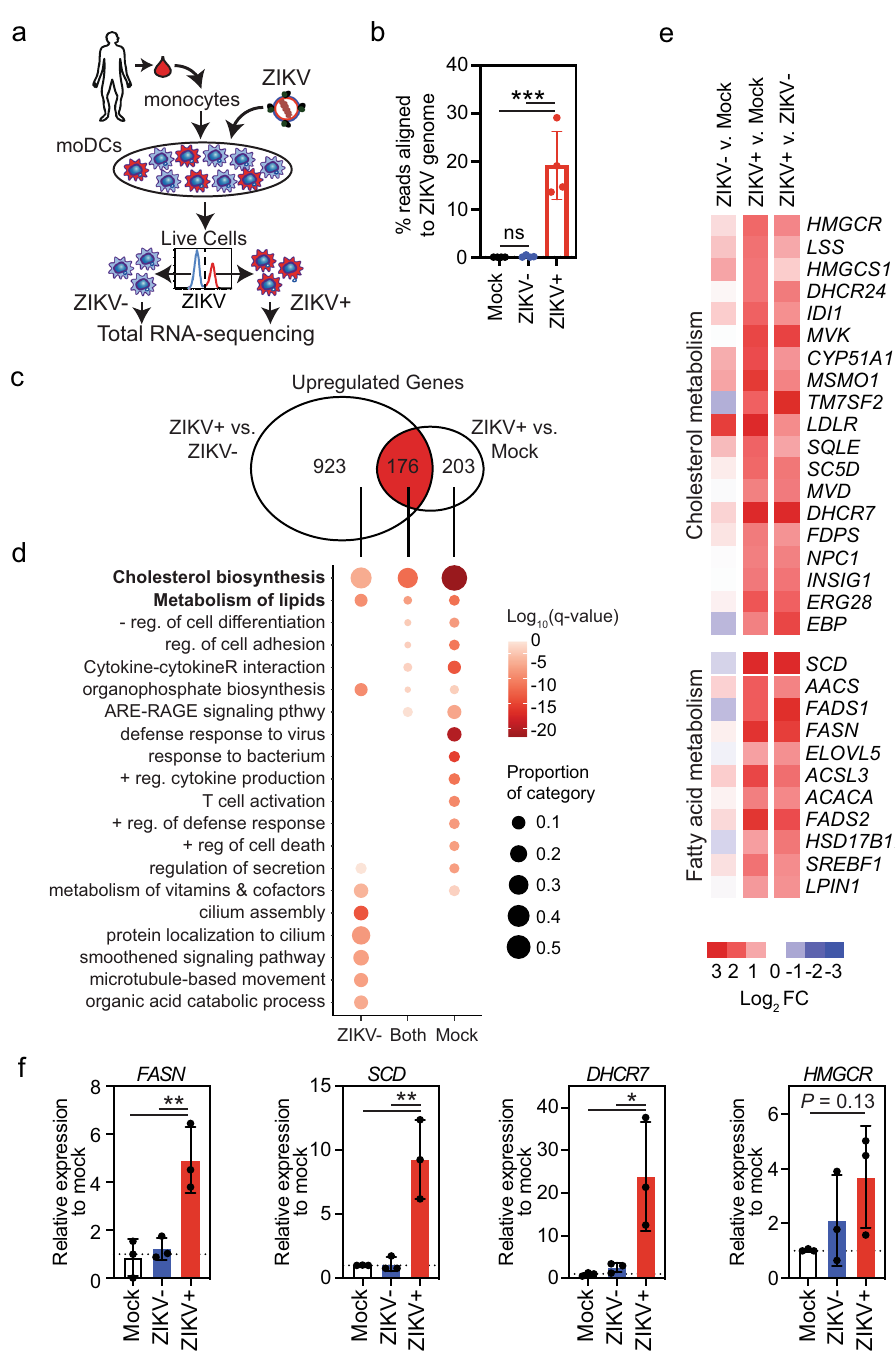
MockmoDCs. d Geneontologyanalysisofgenessigni fi cantlyupregulatedinZIKV+ vs ZIKV − or Mock moDCs. e Heat map of the relative expression of selected genes implicatedinlipidmetabolism. f qRT-PCRanalysisoftherelativeexpressionoffatty acid( FASN and SCD )andcholesterol( DHCR7 and HMGCR )synthesisgenes.Dataare presented as the mean±SD. n =4 ( b ) and n =3 ( f ) biologically independent experiments. Symbolsrepresent moDCsderived from individual donors. * P <0.05, ** P <0.01, *** P <0.001 by one-way ANOVA with Tukey ’ s correction for multiple comparisons. Source data and exact P values are provided as a Source Data fi